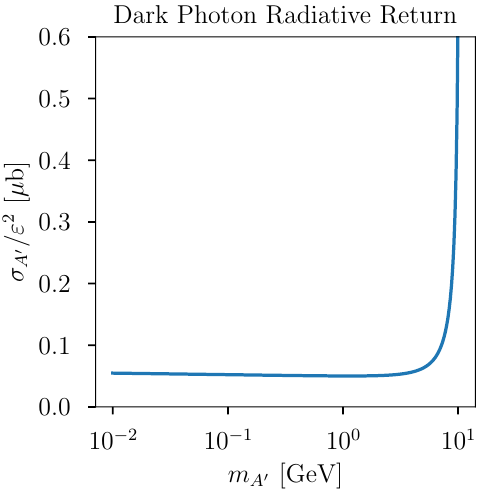
Figure 1 . Radiative return cross section in µ b , divided by squared kinetic mixing, ε 2 , for on-shell dark photon production.